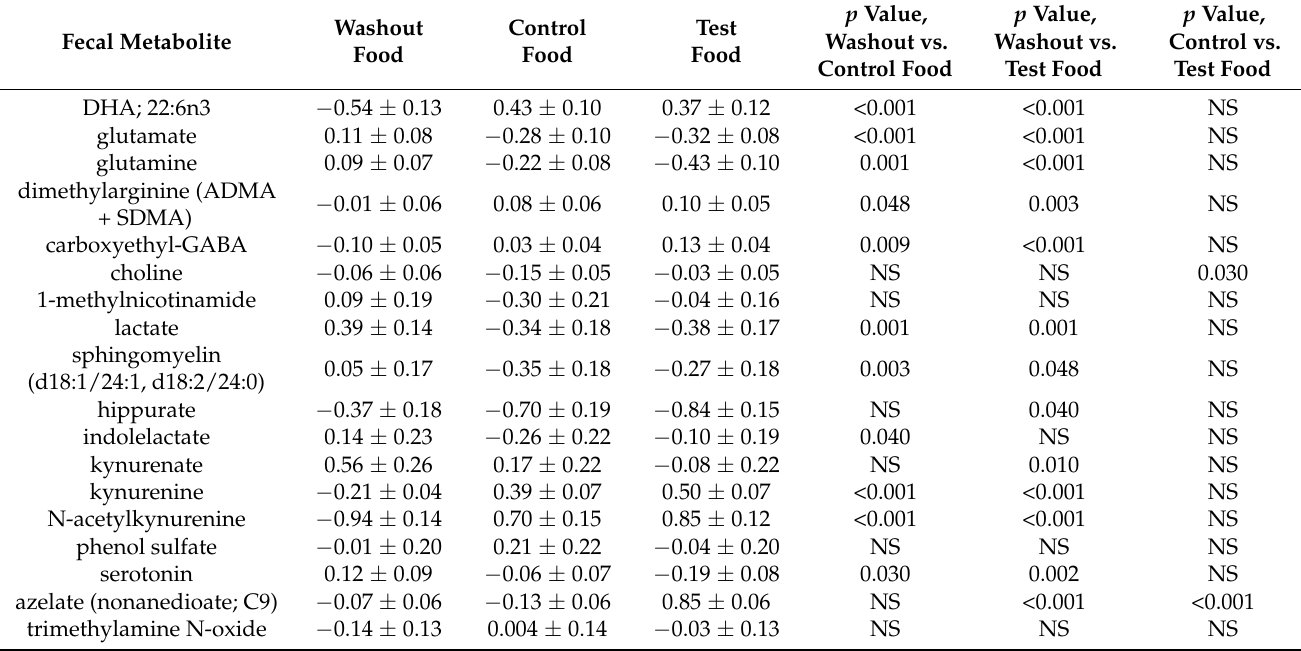
Table 5. Fecal metabolites of